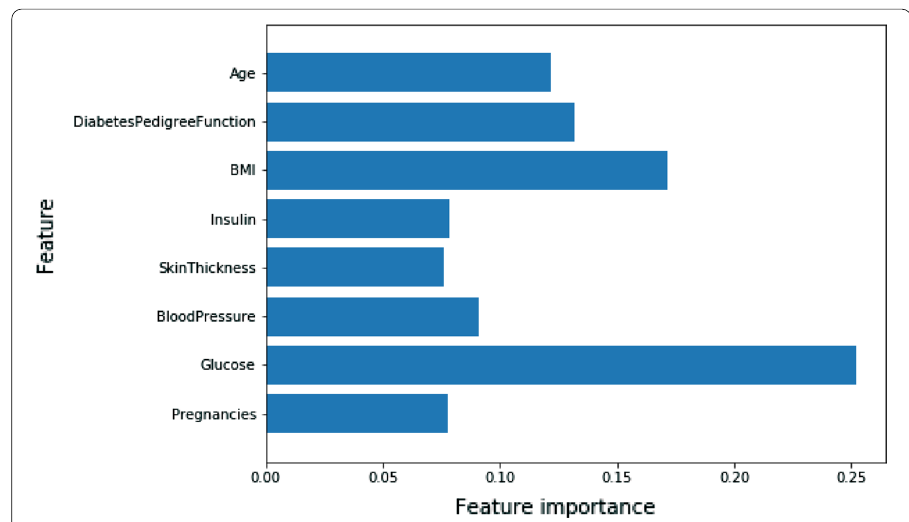
Fig. 19 Feature importance estimated by the proposed algorithm